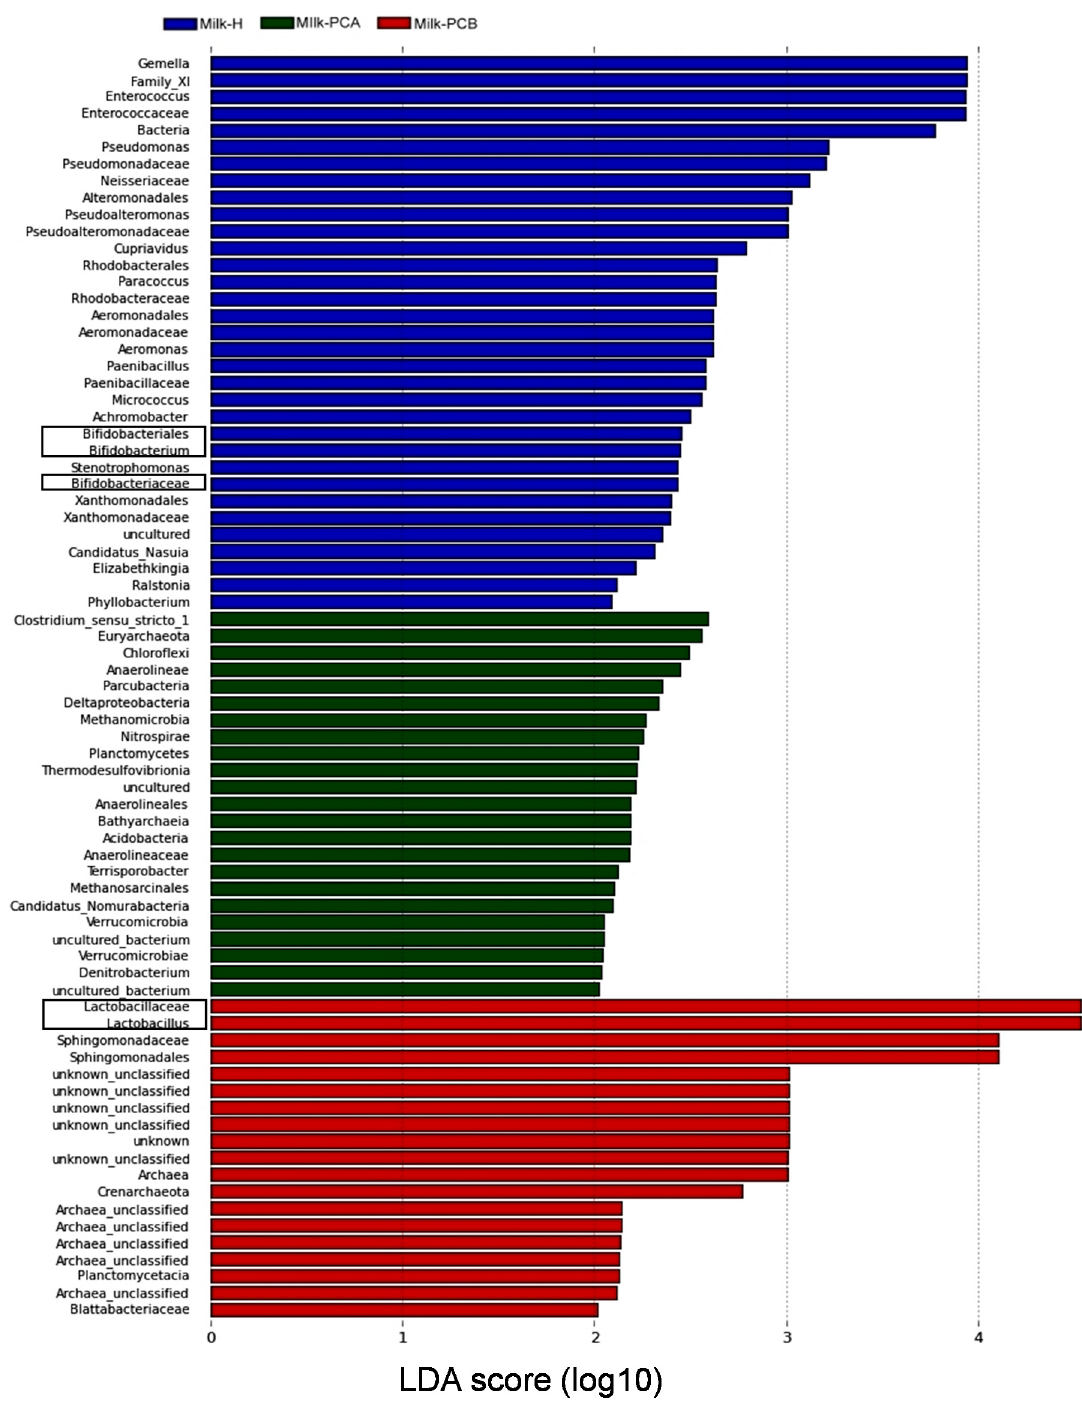
Figure 2. Different abundant microbial taxa between two “doing-the-month” and one “non-doing-the-month” milk groups revealed using a linear discriminant analysis effect size (LEfSe) analysis. The keys for milk-H, milk-PCA, and milk-PCB are described in Table 1. Briefly, milk-H ( n = 46): “non-doing-the-month” milk group; milk-PCA ( n = 14) and milk-PCB ( n = 27): “doing-the-month” milk group. Bar graph showing bacteria that are more abundant in milk-H (blue color), milk-PCA (green color), and milk-PCB (red color) ranked and identified using the linear discriminant analysis (LDA) score. The probiotic bacteria (lactobacilli and bifidobacteria) were indicated in the rectangles within the figure.